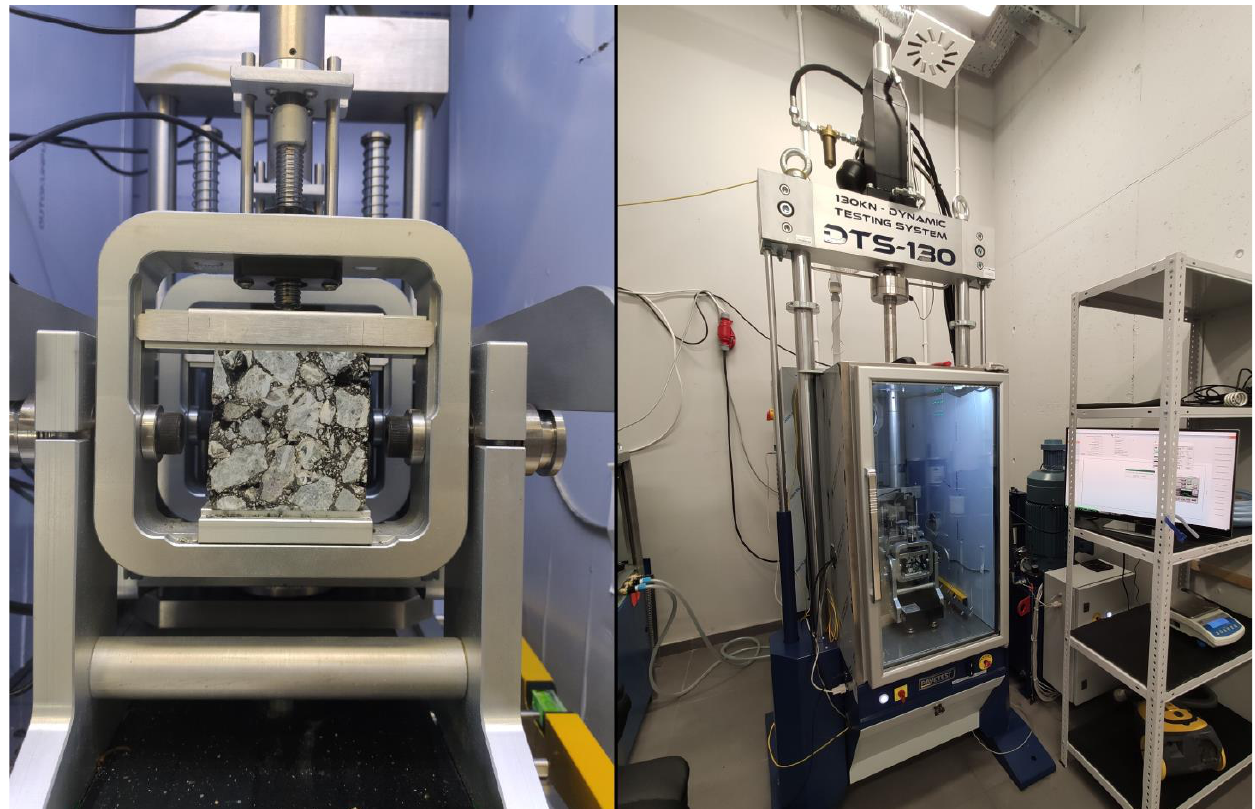
Figure 2. Hydraulic tester machine view.